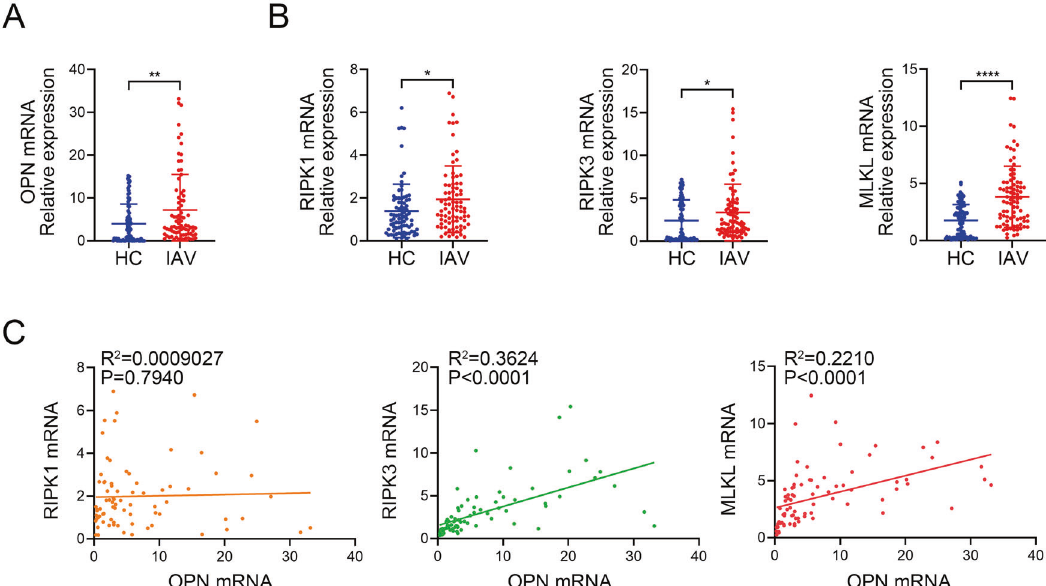
Fig. 1 Positive correlation between Osteopontin (OPN) levels and the levels of necroptosis-related genes in in fl uenza A virus (IAV) patients. A OPN mRNA expression in blood samples from healthy control (HC, n = 82) and IAV patients (IAV, n = 85). B RIPK1, RIPK3, and MLKL mRNA expression in blood samples from healthy control and IAV patients. C Spearman correlation analysis of RIPK1, RIPK3, or MLKL mRNA levels with OPN mRNA levels. Data was analyzed by Student ’ s t test (two-tailed) and expressed as mean ± SEM. Spearman rank correlation was used to test for correlations.* p < 0.05; ** p < 0.01; **** p <